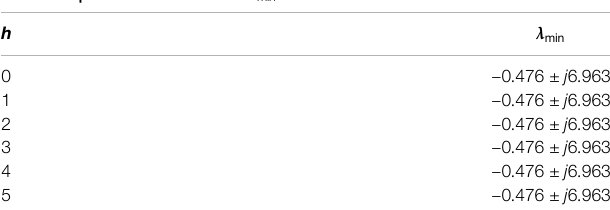
TABLE 6 | Calculation results of. λ min .